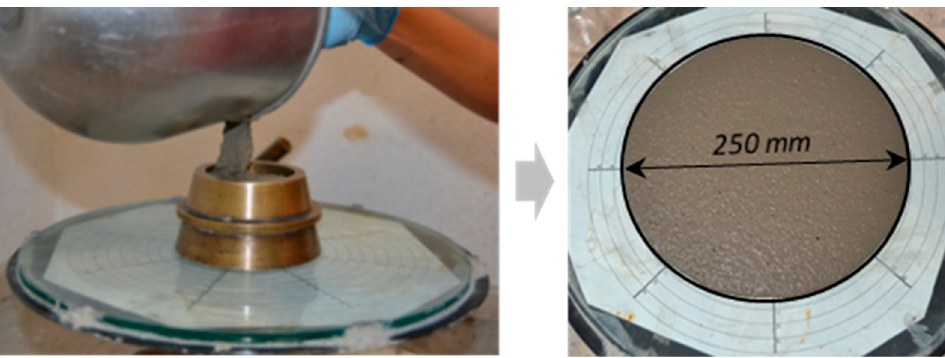
Figure 3. Determination of the consistency of fresh UHPC by shaking table. Spread